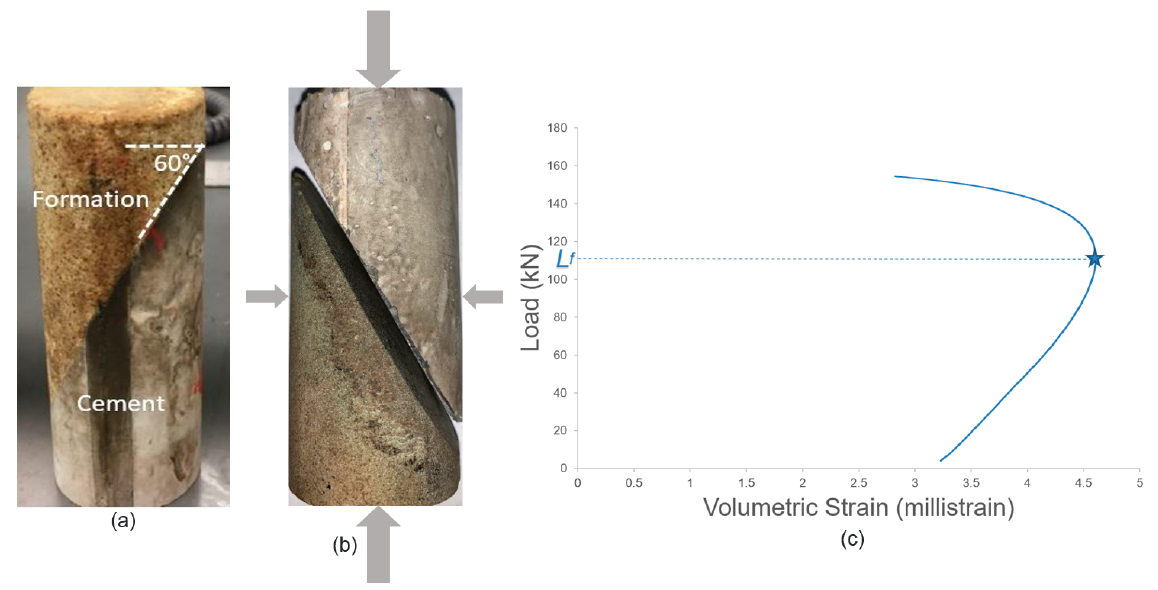
Figure 1. Failure in composite specimen. ( a ) Prior to setting the cement, the formation was cut at 60° to the horizontal in a composite specimen. ( b ) The composite specimen of cement (top) and Berea (bottom). Arrows indicate the direction of applied stresses. Vertical axial stress is applied, as well as confining stress all around the specimen. The size of the arrows indicates the relative magnitudes of the stresses that caused the shear failure. ( c ) Load versus volumetric strain data obtained from one of our specimens. Failure in a specimen is recognized when volumetric strain rolls over (at the star point).